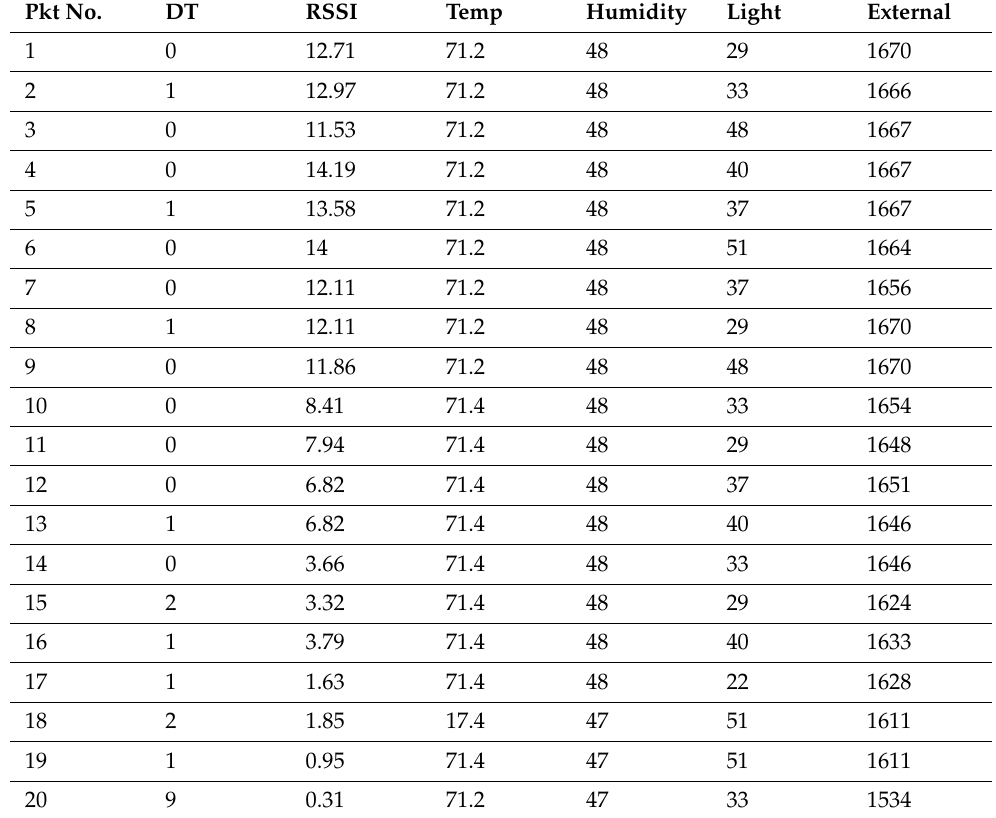
Figure 12. Sensor Device Placement for Dipole Antenna. Table 1. Patch Antenna Sensed Data. Table 4. Data Sensed in a Mobile